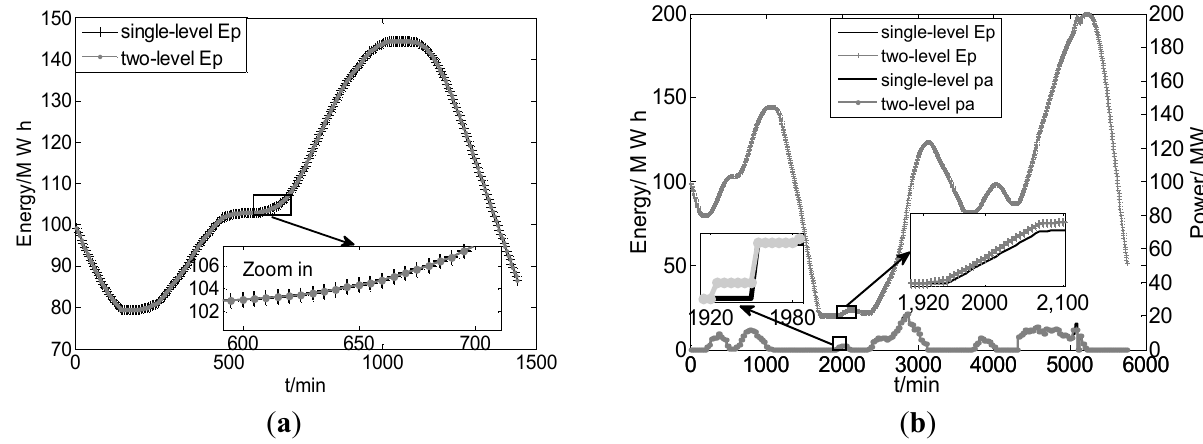
Figure 13. Operating states of pumped storage. ( a ) one day states of the pumped storage; ( b ) four days states of the pumped